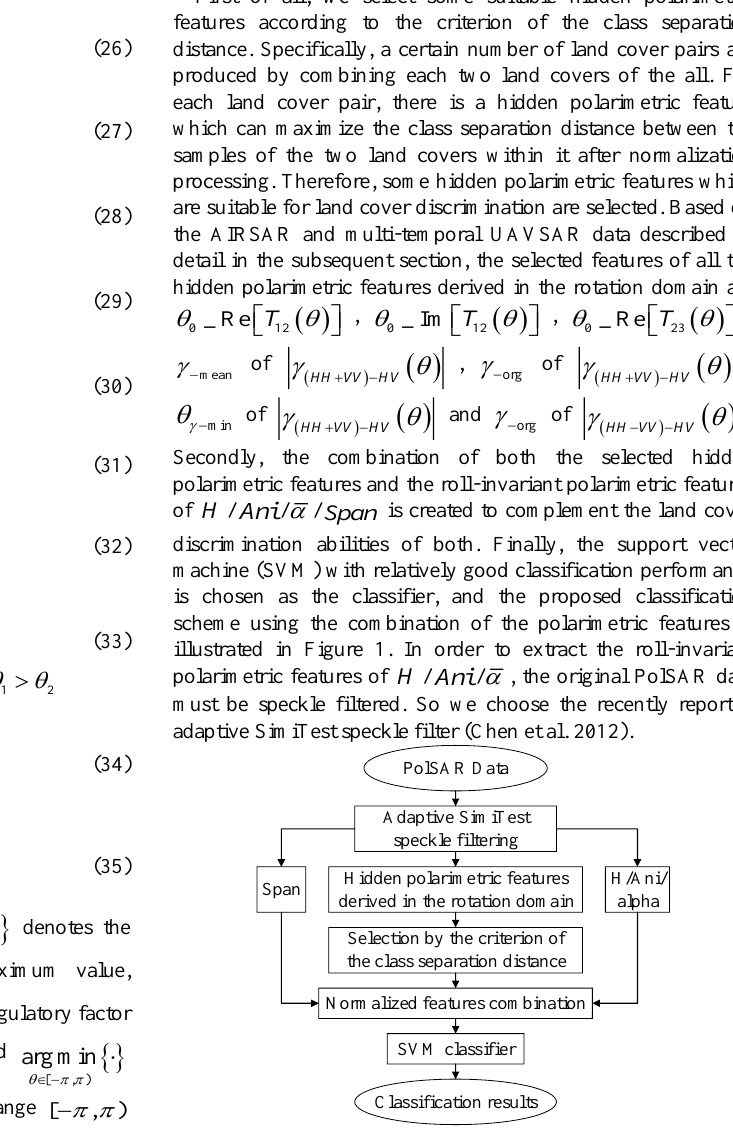
Figure 1 Flowchart of the proposed classification